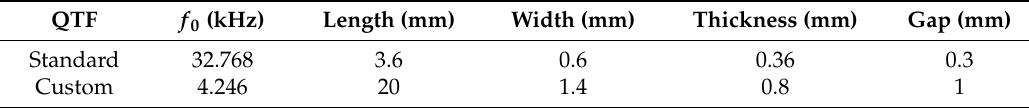
Table 1. Parameters for standard and custom